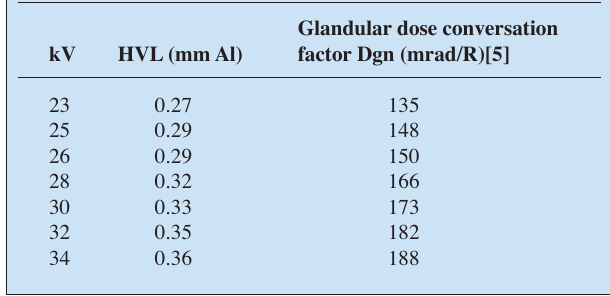
Table I. Kilovoltage (kV) range and half-value layer (HVL) in millimetres of aluminium (Al); information used to calculate average glandular dose from entrance exposure